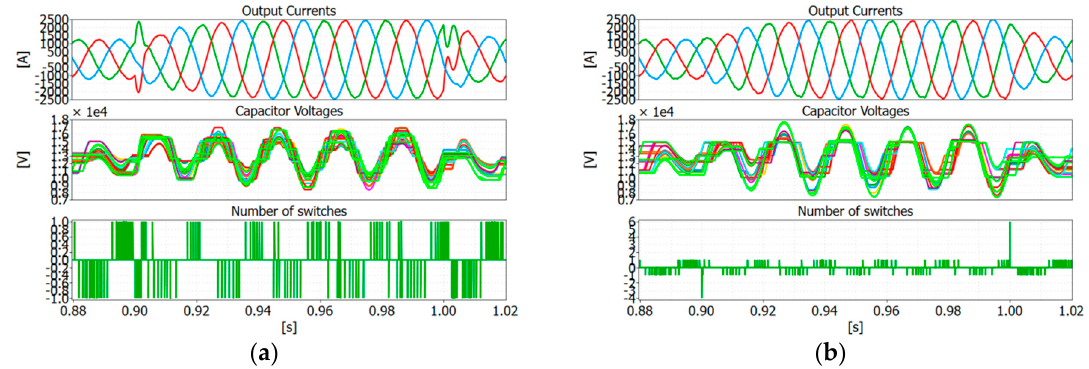
Figure 9. Output currents, capacitor voltages and number of switches per each Ts in simulation during phase to phase fault: ( a ) Max/min approach; ( b ) proposed mapping strategy M = 8 with the switching frequency optimization.